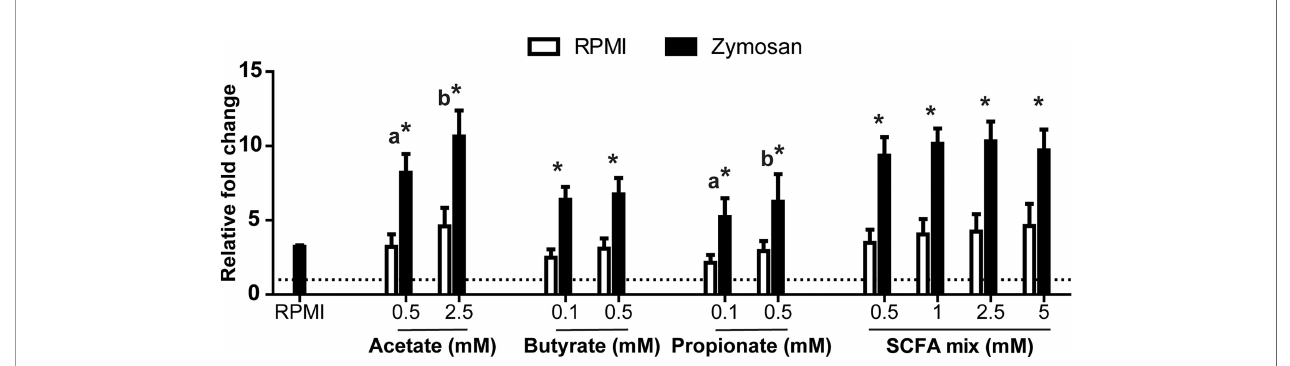
FIGURE 5 | SCFA increased oxidative burst in head kidney leukocytes (HKL). Total production of reactive oxygen species (ROS) relative to unstimulated HKL (dotted line). Cells were exposed to different concentrations of SCFAs in the absence (medium control (RPMI), open bars) or presence (black bars) of zymosan (50 µg/ml). Immediately following exposure, ROS production was measured real-time over a period of 2 h. Bars indicate mean ± SD of n = 5 experiments performed independently. Asterisk (*) indicates signi fi cant difference between ROS production induced in the presence (solid black bars) or absence of Zymosan (open white bars) assessed by the linear mixed model followed by the Bonferroni post hoc test. Groups with different letters are statistically different from one another, within one treatment (acetate, butyrate, propionate or SCFA mix) where “ a ” indicates the lowest